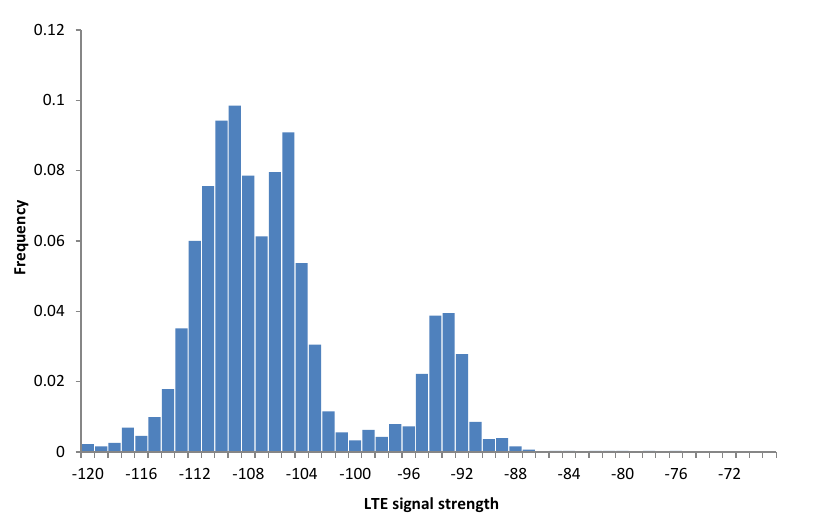
Figure 11. Signal strengths for all evaluated tablet devices (Experiment